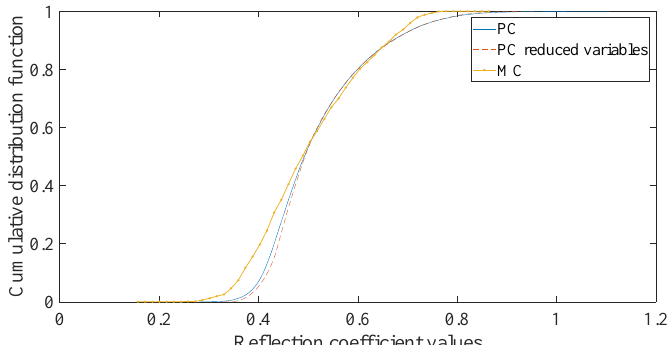
Figure 11. Cumulative distribution function for the first case of the patch-antenna problem.